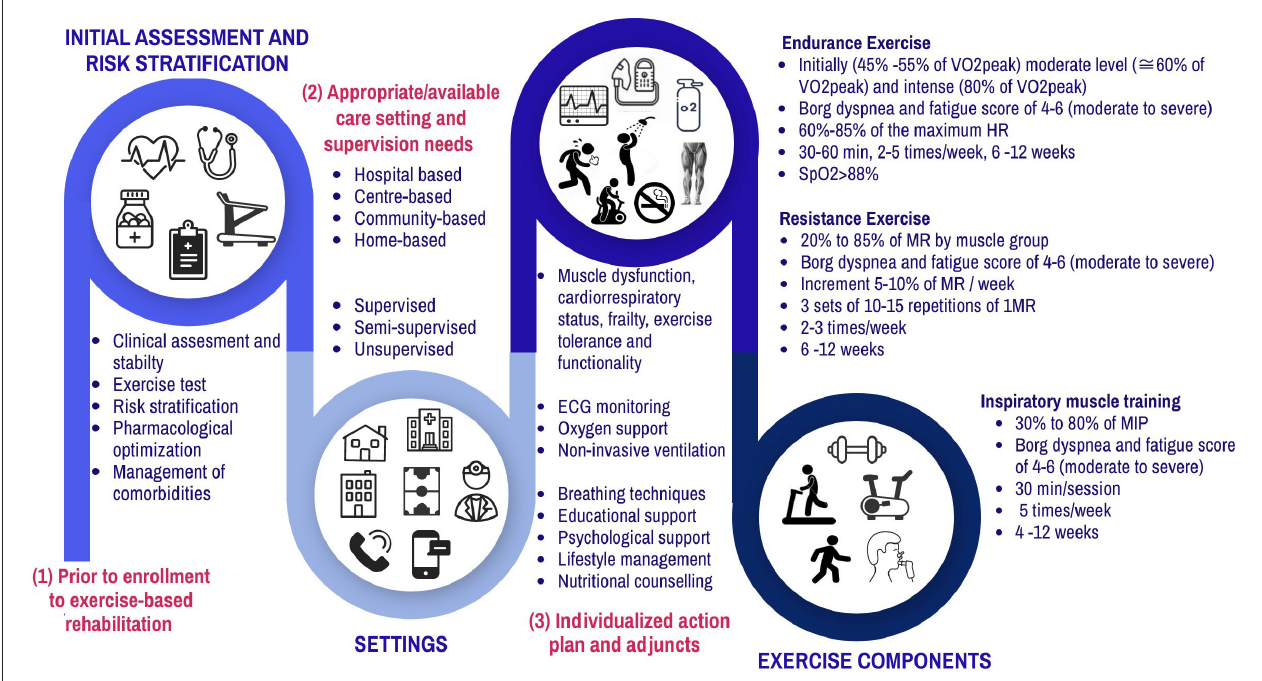
FIGURE 1 | Summary of components of Exercise-based rehabilitation on the population with COPD-CHF or COPD-Cardiovascular comorbidities. V O 2peak , oxygen consumption; HR, heart rate; MR, maximum repetition; MIP, maximum inspiratory pressure; SpO 2 , Peripheral oxygen